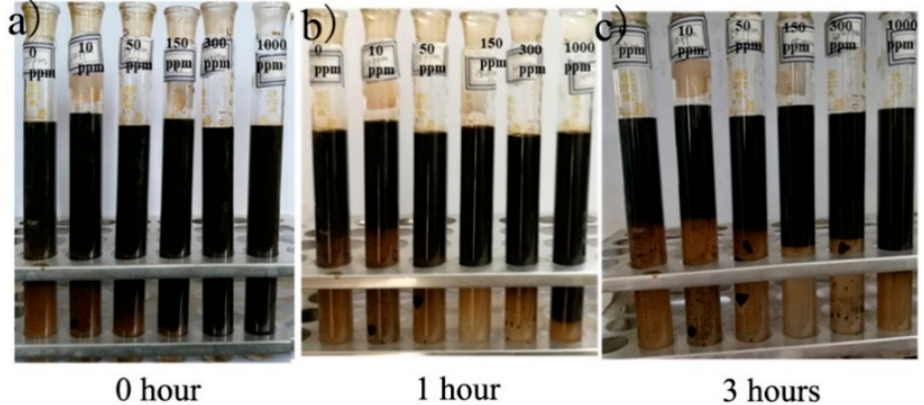
Figure 10. Gravity separation process: ( a ) 0.1 h, ( b ) 1 h, and ( c ) 3 h, operating condition O/W = 20/80, HPAM = 50 ppm, shear rate = 5000 rpm.